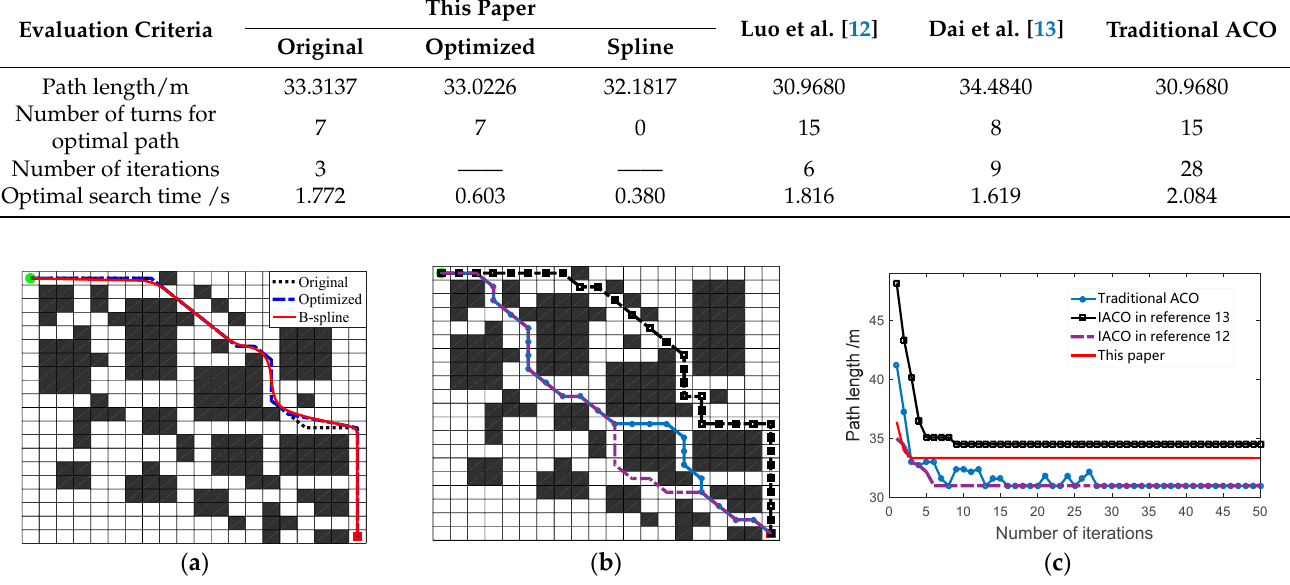
Figure 16. Comparison diagram of path planning; ( a ) Optimal path diagram of this paper; ( b ) Optimal path diagrams of other algorithms; and ( c ) Optimal path iteration diagram.